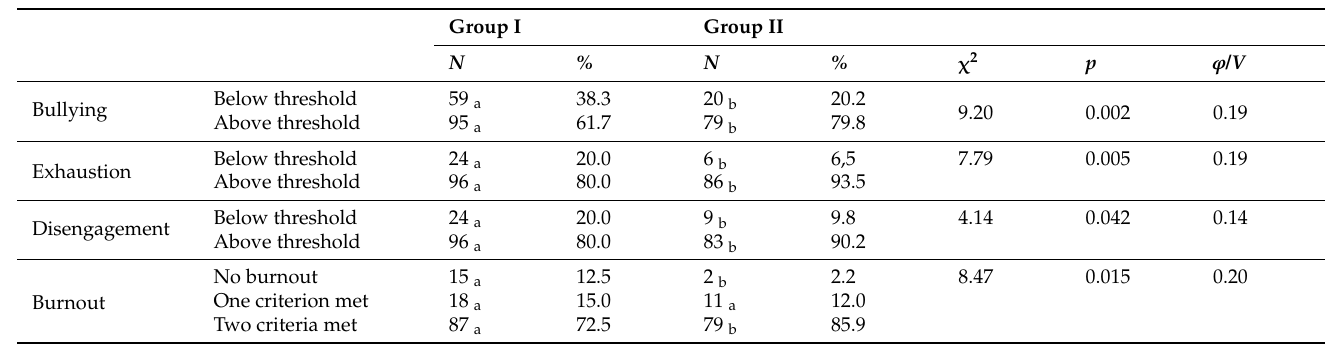
Table 3. Relationship between burnout and its dimensions and bullying prevalence in Group I and Group II.